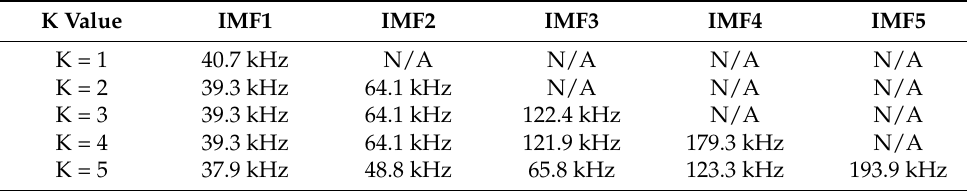
Table 1. K from 1 to 5, the center frequency of IMFs after VMD.